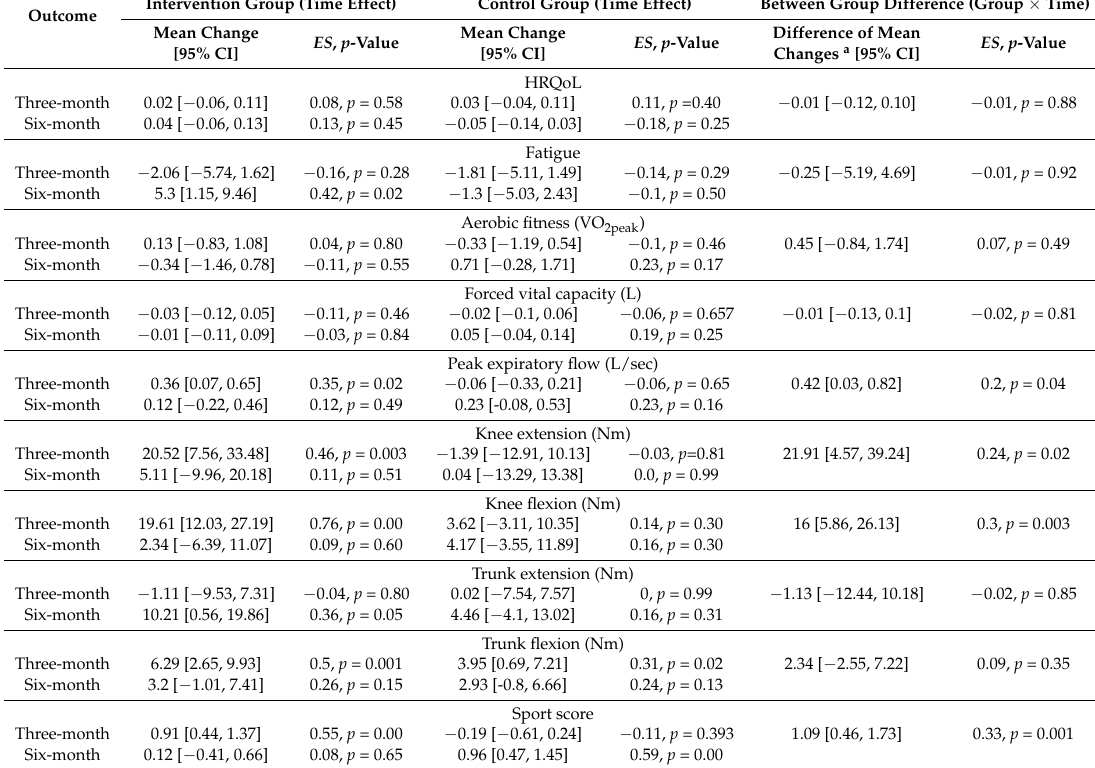
Table 3. Time effects and between group effects at three and six months after baseline assessment.